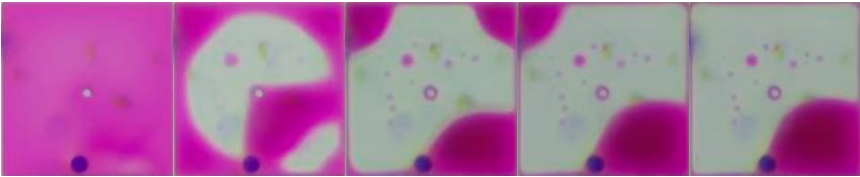
Figure 5. The ink formation change process in the driving process of a pixel.